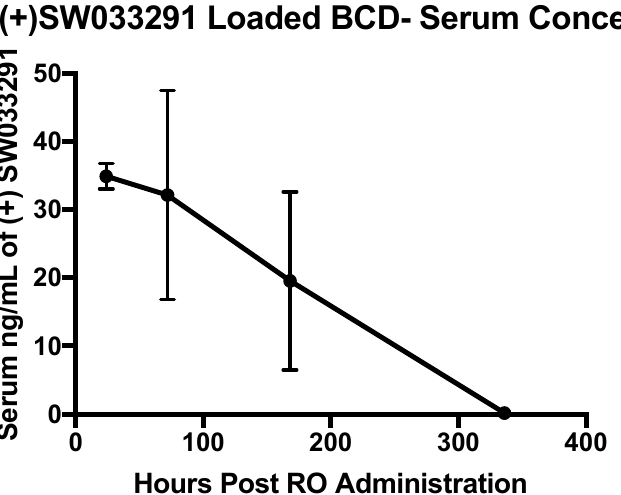
Figure 6. Serum (+)SW033291 concentrations collected from mice ( n = 4 at each timepoint) following RO administration of (+)SW033291 loaded β-CD MPs. Error bars are representative of the standard error of the mean.